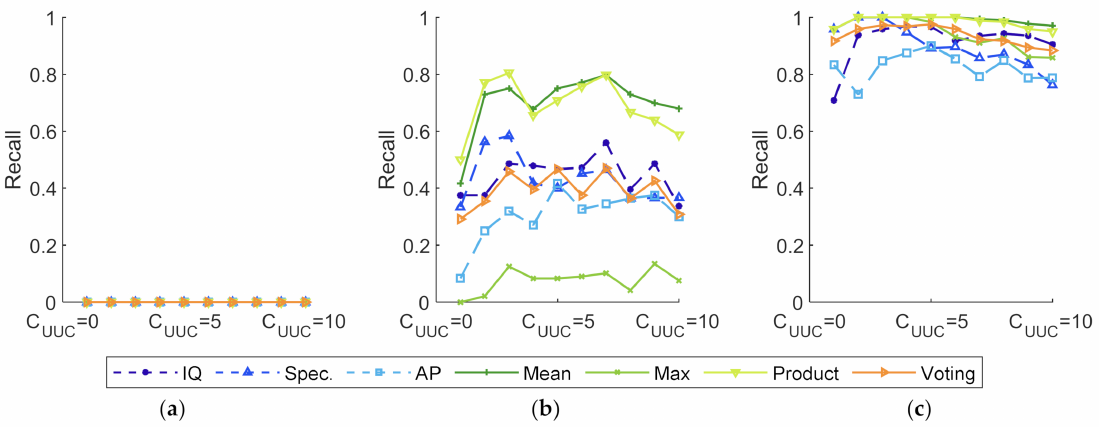
Figure 13. Recall of experiments with various C UUC and classifiers. ( a ) Softmax as basic classifiers; ( b ) softmax-threshold as basic classifiers; ( c ) OpenMax as basic classifiers.